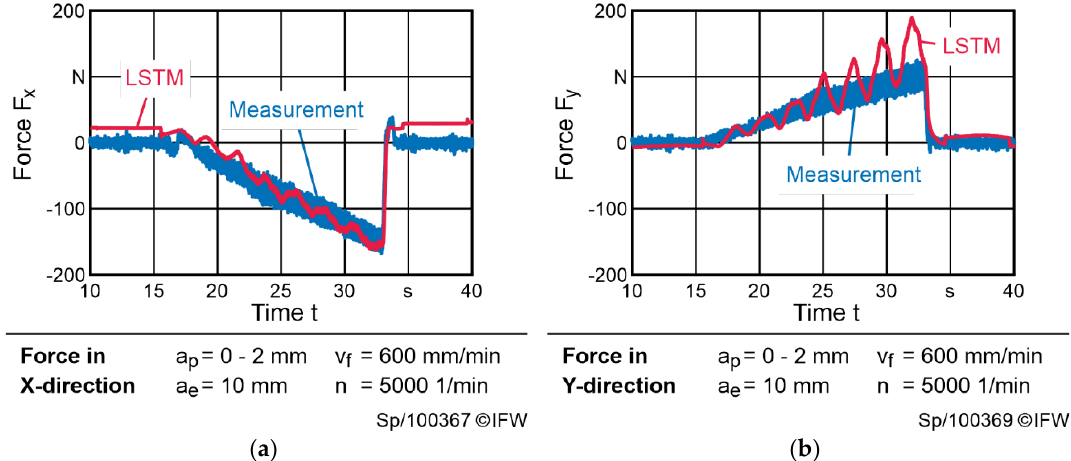
Figure 9. Comparison between measured process forces and the result of the LSTM during ramp milling in negative Y -direction and positive Z -direction: ( a ) force acting in X -direction; ( b ) force acting in Y -direction.